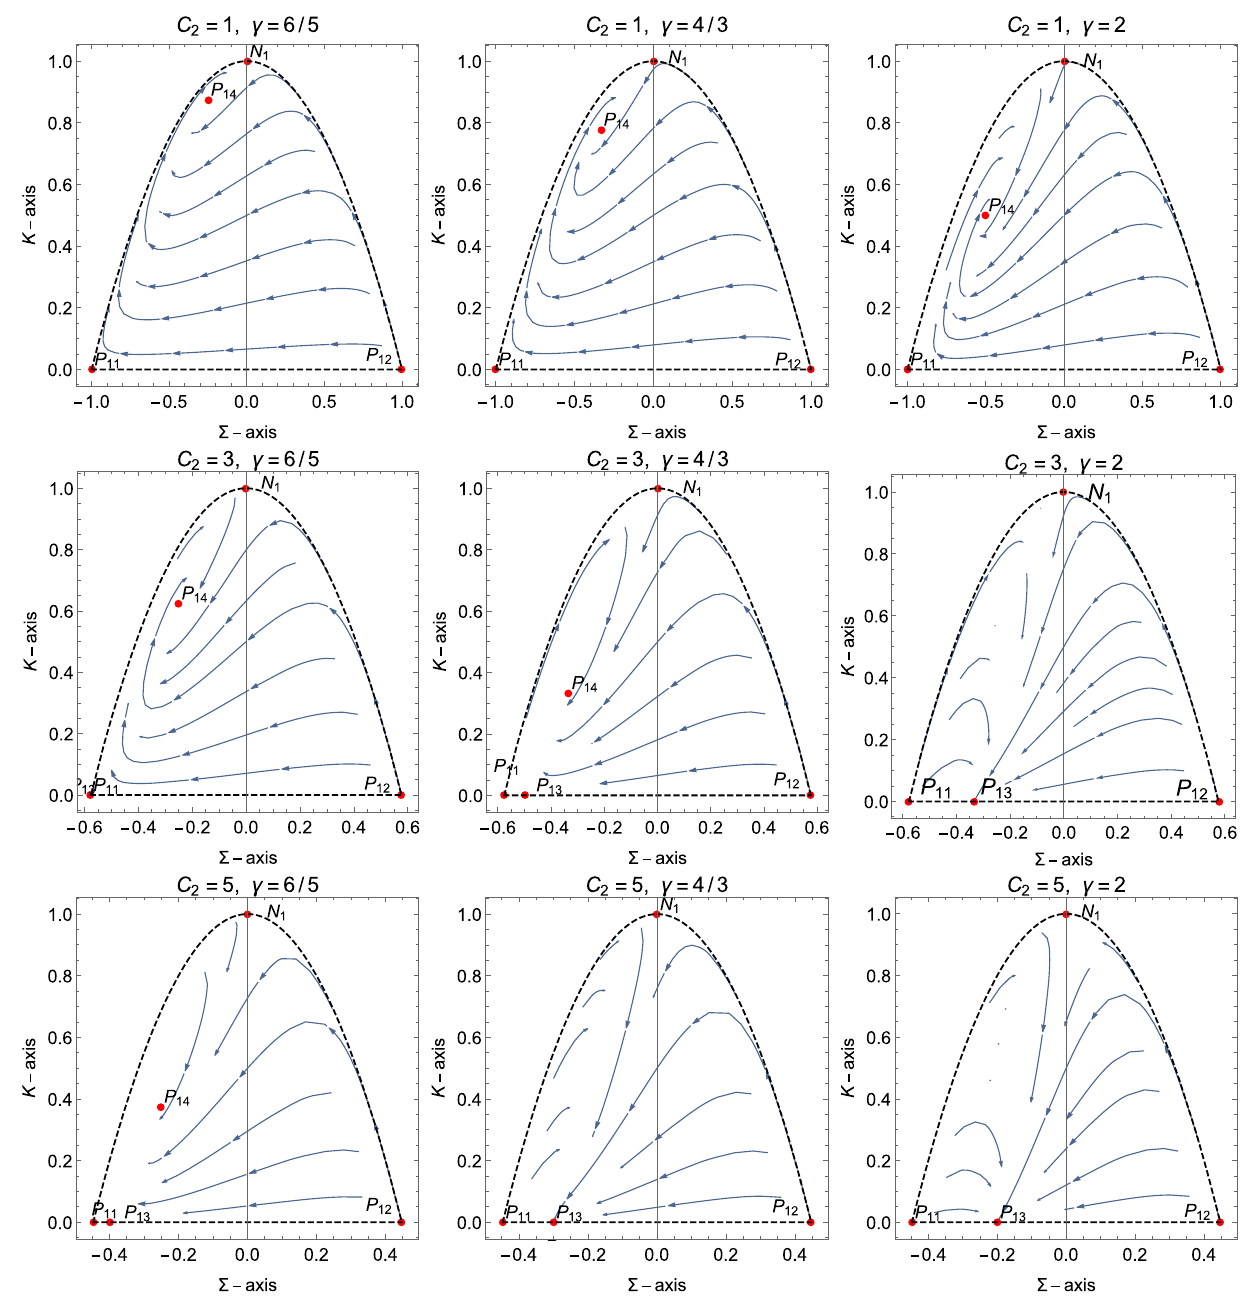
Fig. 9 Orbits of system (77) with v = 0 , A = 0 with 1 < γ ≤ 2 for different choices of γ and C 2 The authors in [67] used the notation Kernel sgn there is no confusion sgn (v) or sgn (Σ) is omitted. The ker- nel indicates the interpretation of the point: M , C represent Minkowski spacetime; K represents a Kasner solution; T corresponds to static solutions; SL ± corresponds to a flat FLRW space and static orbits depending on the parameter γ ; The equilibrium point line H − is associated with a change